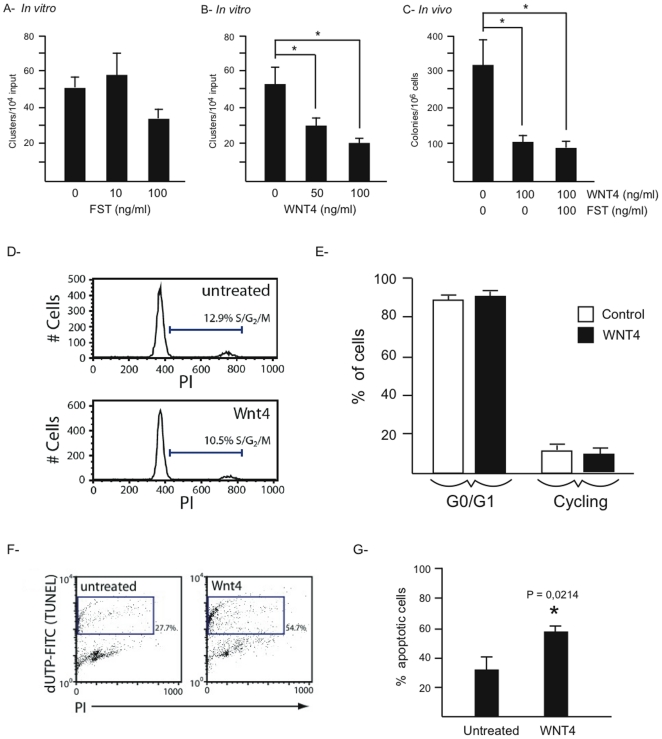
WNT4 downregulates SSC activity in vitro.(A, B) Germ cell cluster formation ability of cells treated with the indicated concentrations of FST (A) or WNT4 (B). (C) Colony numbers obtained after transplantation of germ cells treated with WNT4 or WNT4 and FST at the indicated concentrations. (D, E) Representative flow cytometric histograms (D) and analysis (E) showing the cell cycle profiles of cultured germ cells, with or without prior WNT4 treatment (100 ng/ml). (F, G) Representative scatter plots (F) and analysis (G) showing TUNEL assay results of germ cells following WNT4 treatment (100 ng/ml). All data are expressed as mean (columns) ± SEM (error bars). Significant differences from controls (P<0.05) are indicated with an asterisk (*) and accompanied by relevant P values.